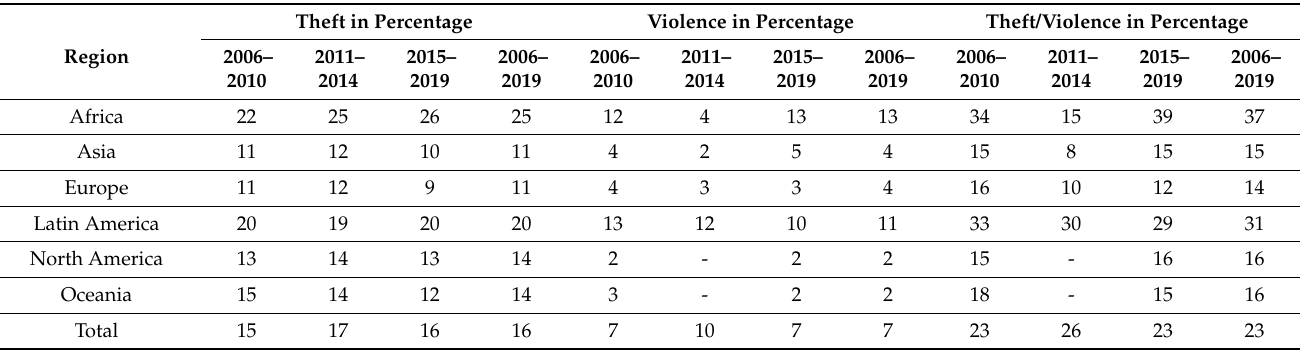
Table 1. Prevalence of theft, violence (assault/mugging) and theft and/or violence in Africa, Asia, Europe, America, and Oceania (Data: GWP 2006–2019).